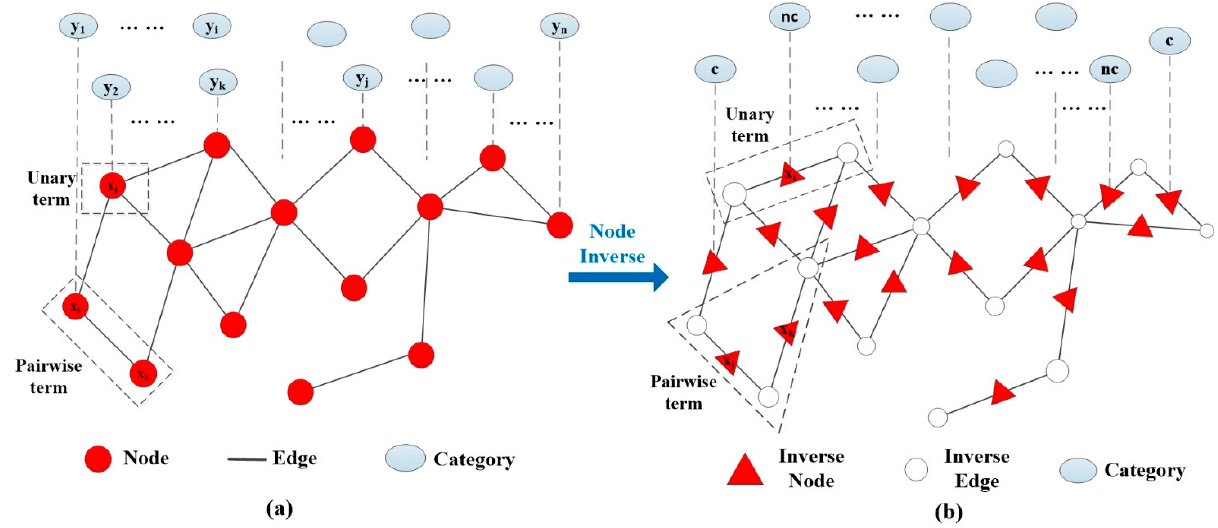
Figure 2. Depictions of regular graph and inverse node graph. ( a ) Regular graph. ( b ) Inverse node graph. Where all nodes and corresponding lables do not list all in figure, using the ellipsis instead.